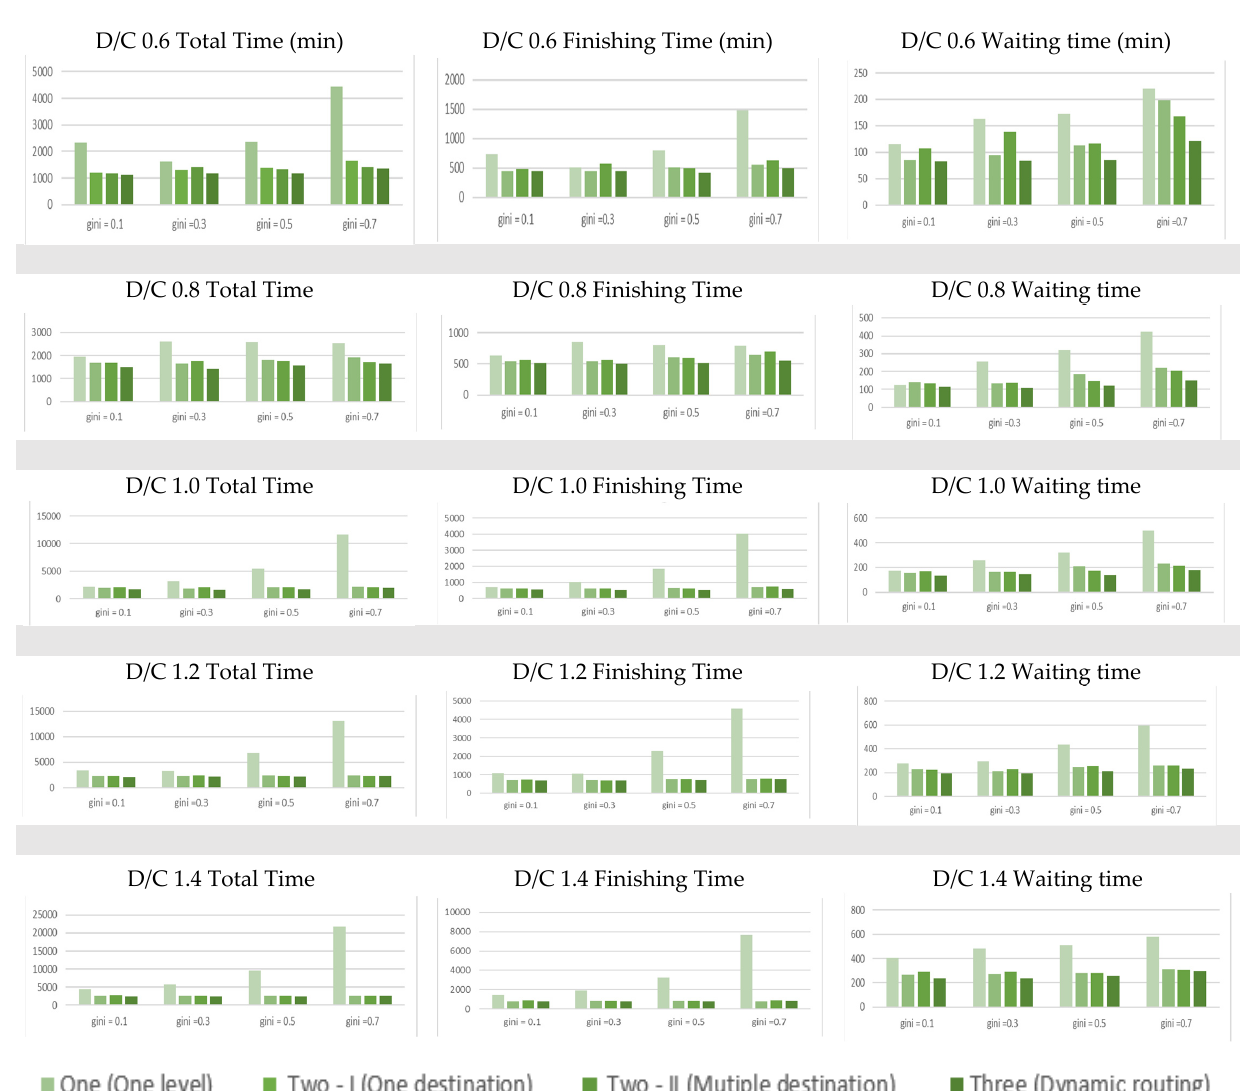
Figure 9. Simulation results.